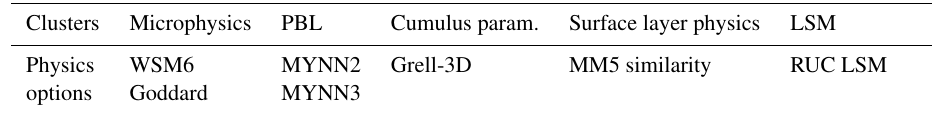
Table 4. Four select physics configurations of Set 4 (2 × 2 × 1).